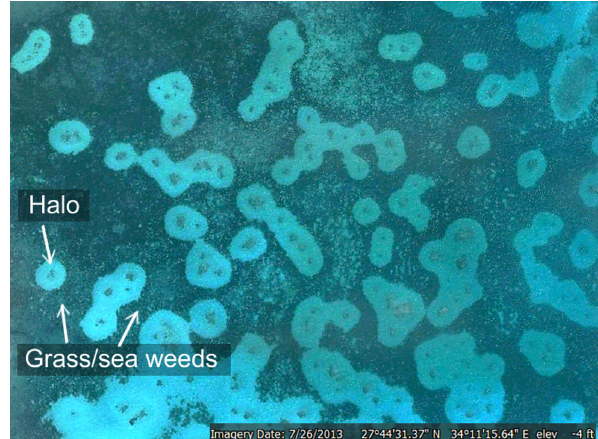
Figure 2. Coral reef patches surrounded by halos of sand produced by herbivore members of a patch assemblage (fish, mollusks, and sea urchins) who remove sea grass and algae. Boundary of the patch assemblage is visible where halo contrasts with the grass and algae area but requires different identification criteria when two or more halos meet. A typical single patch halo is about 25–45m across, with a darker coral patch at the center ranging from 5–15m in di- ameter. Image copyright 2014 CNES/Astrium.